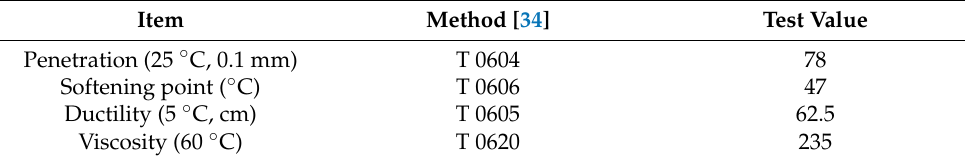
Table 1. Basic Properties of Penetration Grade 70/100 Asphalt.